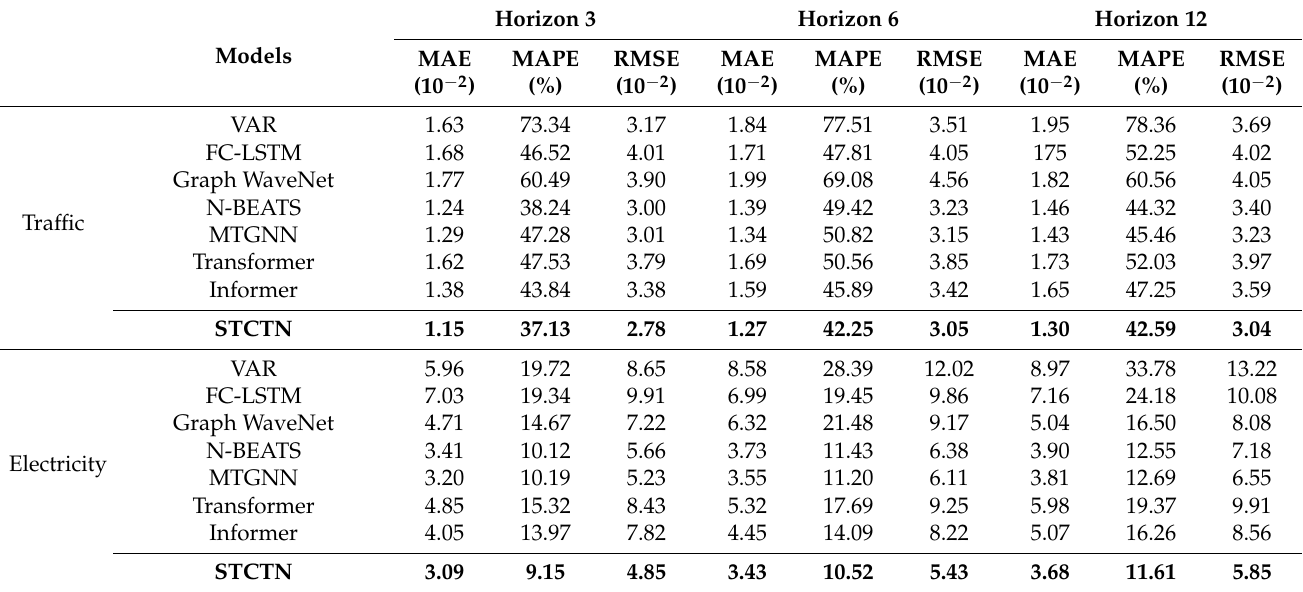
Table 3. Performance comparison of different approaches on datasets without priori graph